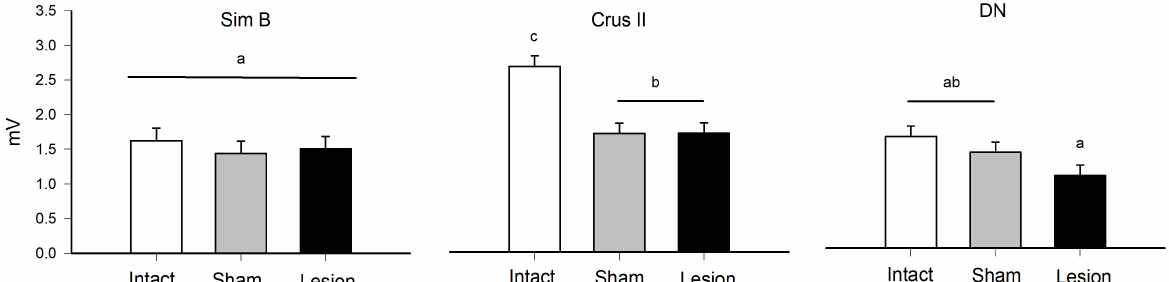
Figure 3. Representative traces of three-second multiunit activity were obtained during horizontal